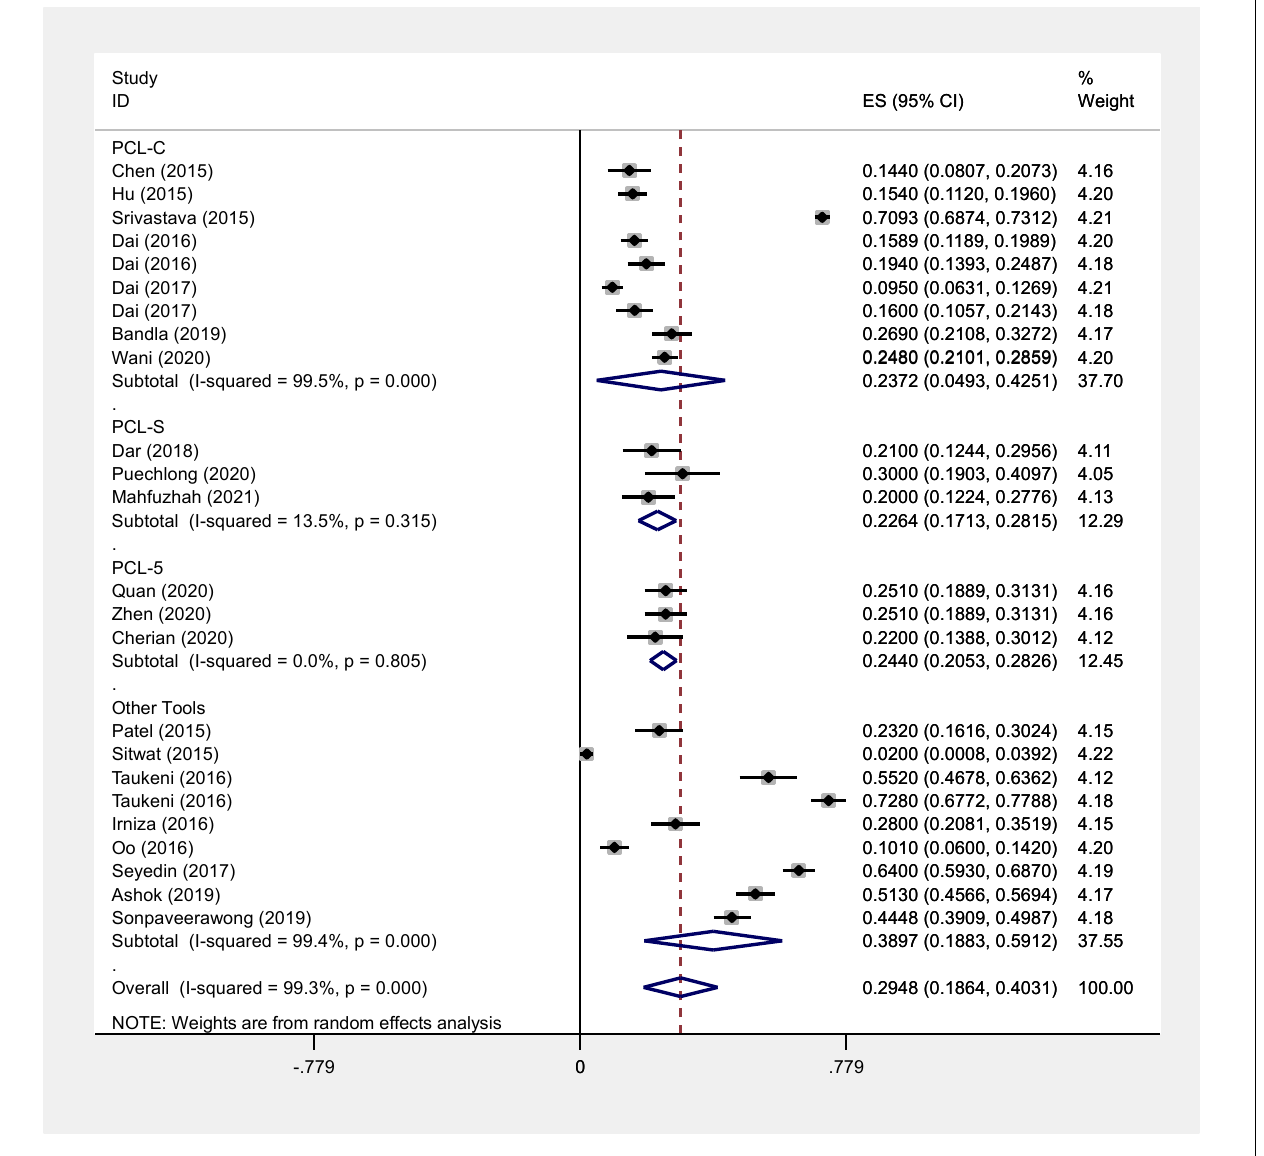
FIGURE 2 | Forest plot of the prevalence of PTSD after the flood in general and separately with 95% confidence interval.